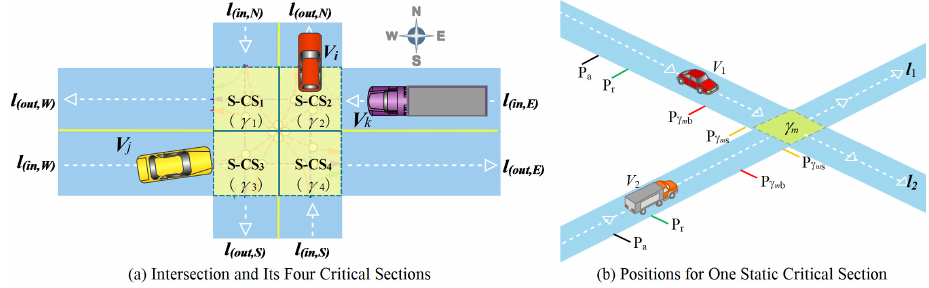
Figure 2. Intersection and Its Composed S-CSs. ( a ) Intersection and Its Four Critical Sections. ( b ) Positions for One Static Critical